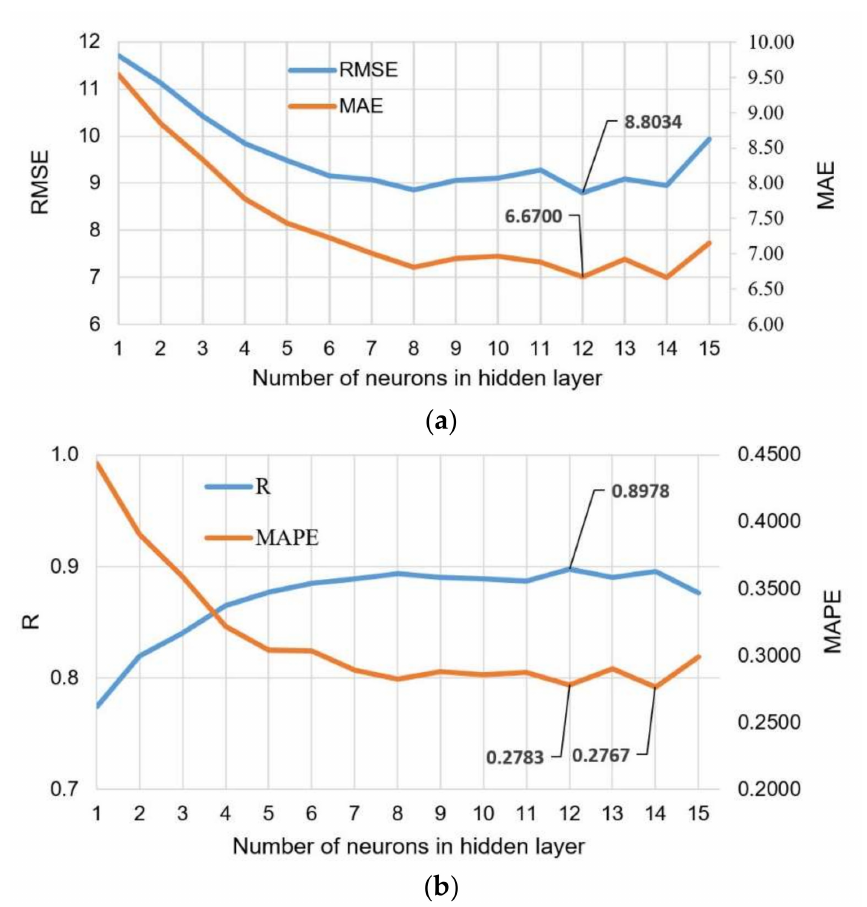
Figure 18. Comparison of the accuracy criteria for MLP-ANNs with different numbers of neurons in the hidden layer: ( a ) RMSE and MAE; and ( b ) R and MAPE.